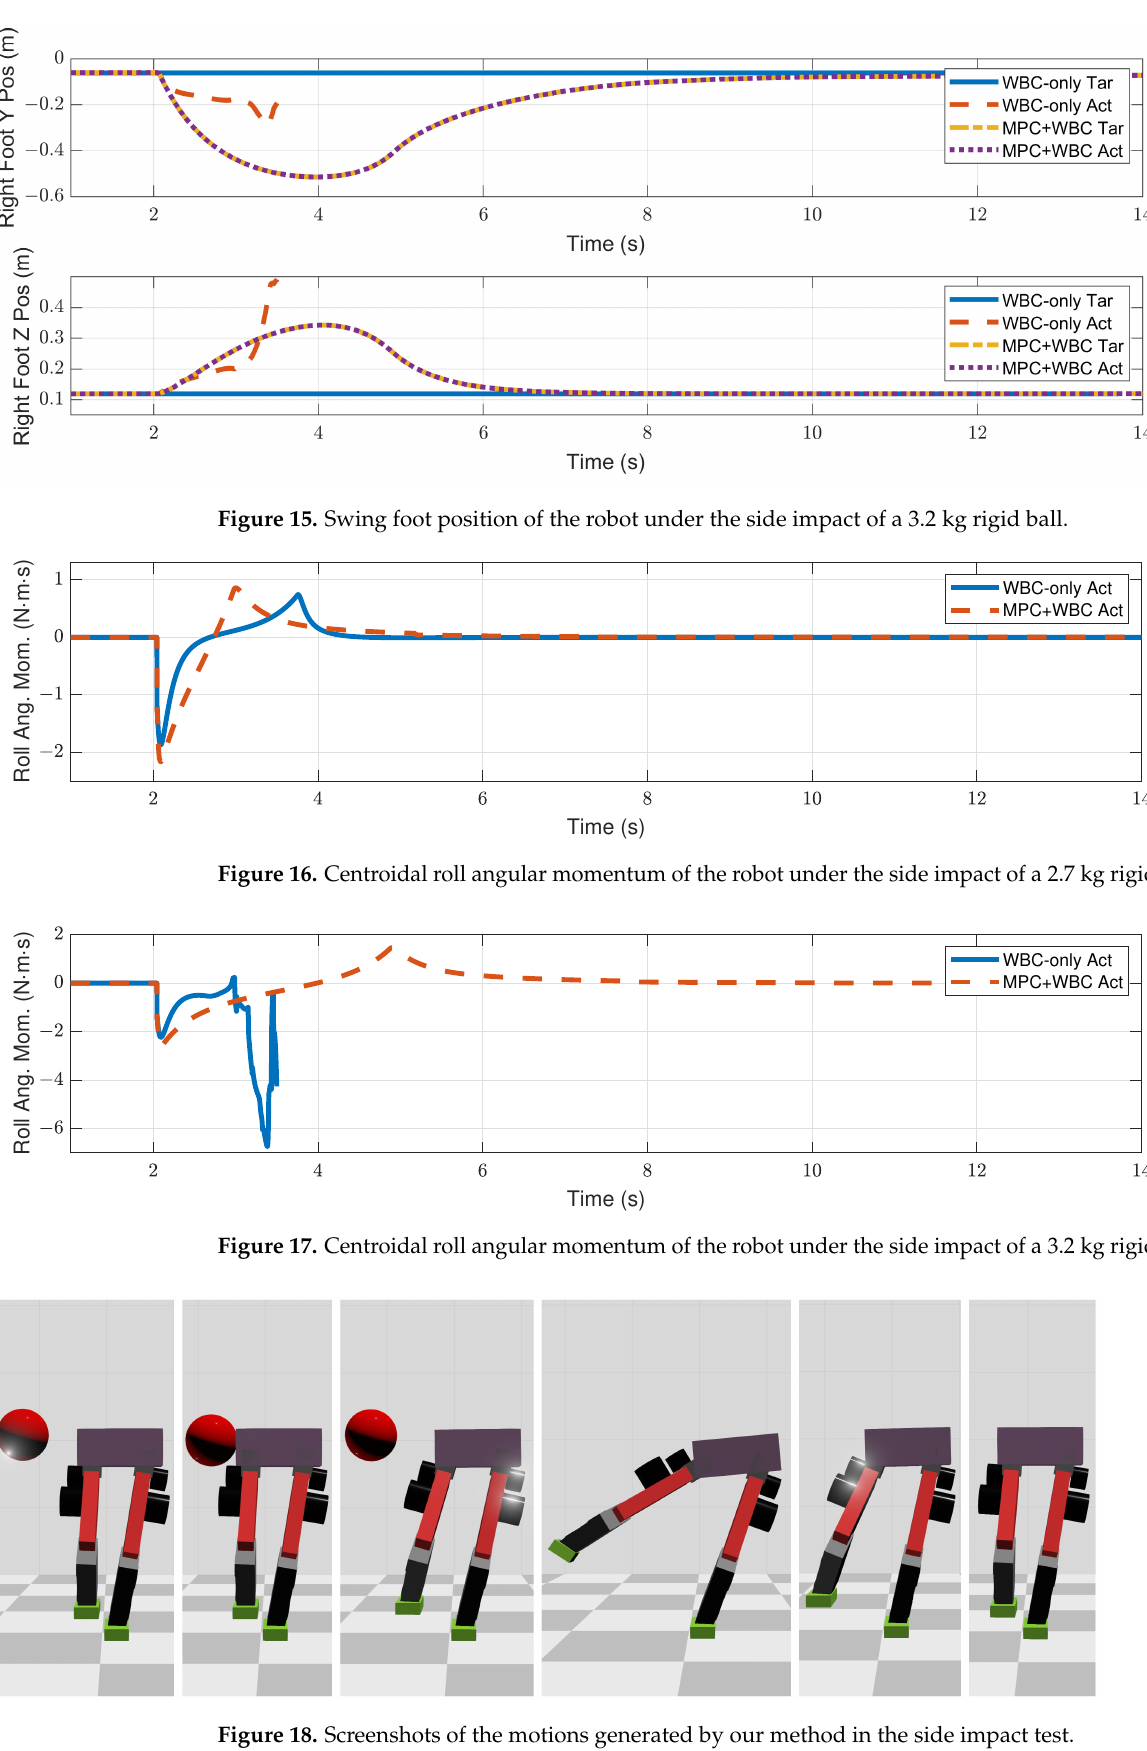
Figure 18. Screenshots of the motions generated by our method in the side impact